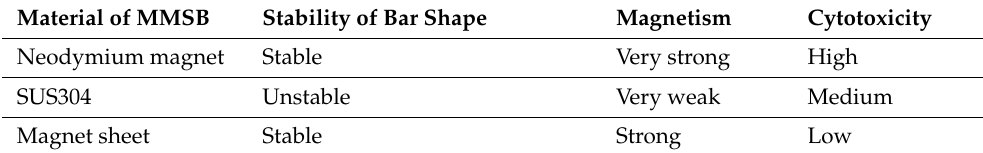
Table 1. MMSB of material type and properties.